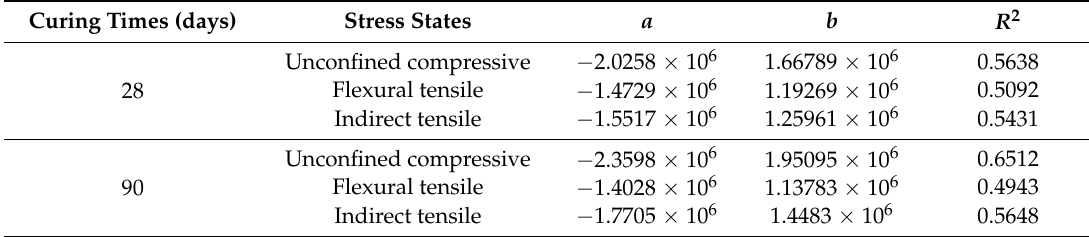
Figure 8. Fitting curve for the fatigue equation for a cement content of 5% under different stress states. Table 5. Fitting parameters for the fatigue equation with a cement content of 3% under different stress